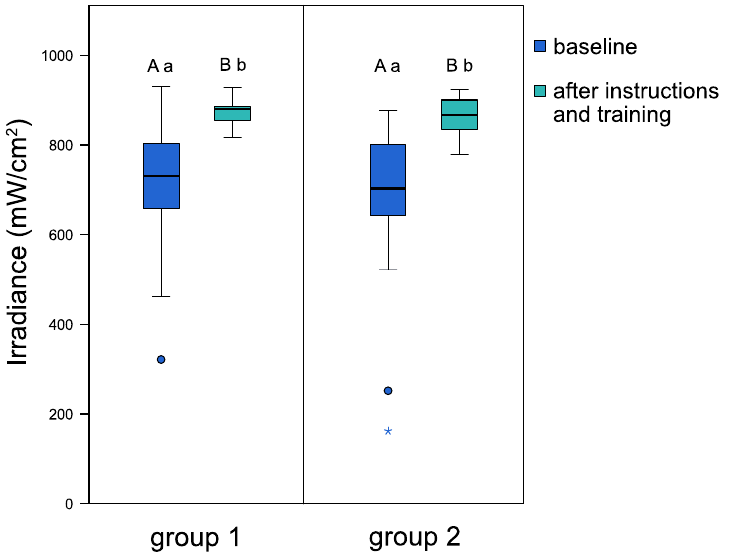
Figure 2. Light irradiance (mW/cm 2 ) achieved by the two groups of dental students at baseline and after individual instructions and training with the MARC Patient Simulator. The boxplots show the medians (bold black lines) and the boxes represent the 25 % and 75 % data quartiles, whereas the whiskers represent 1.5 × interquartile range (IQR), or minima and maxima of the distribution if below 1.5 × IQR; outliers are shown by circles, and extreme outliers are presented by asterisks. Groups marked with different uppercase letters (intra-group comparisons) or different lowercase letters (inter-group comparisons) are significantly different from each other ( p < 0.05).